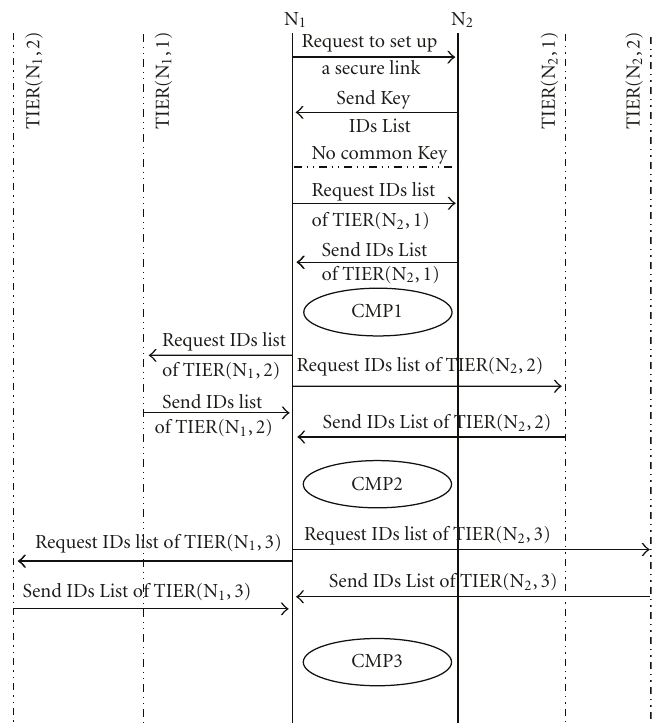
Figure 2: Proxy process discovery.